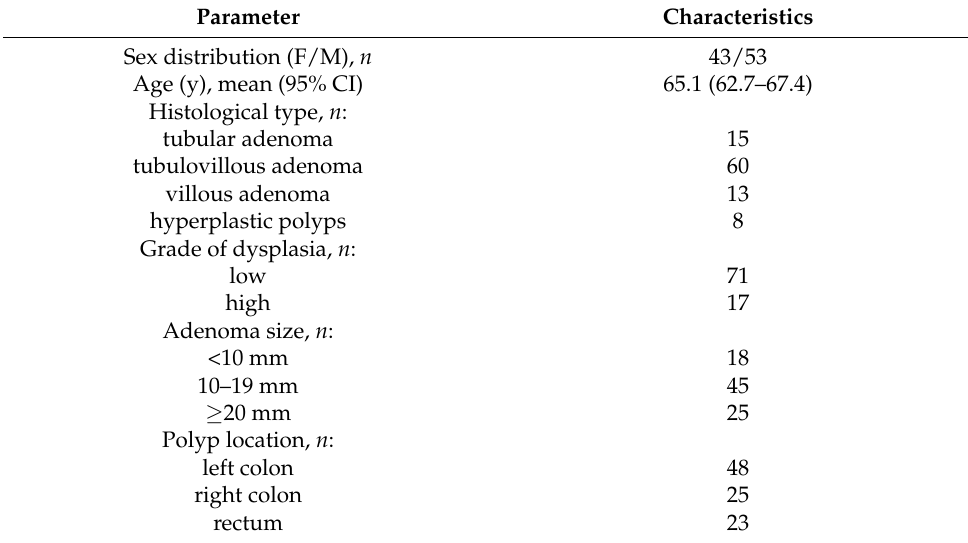
Table 1. Characteristics of patients with colorectal polyps.